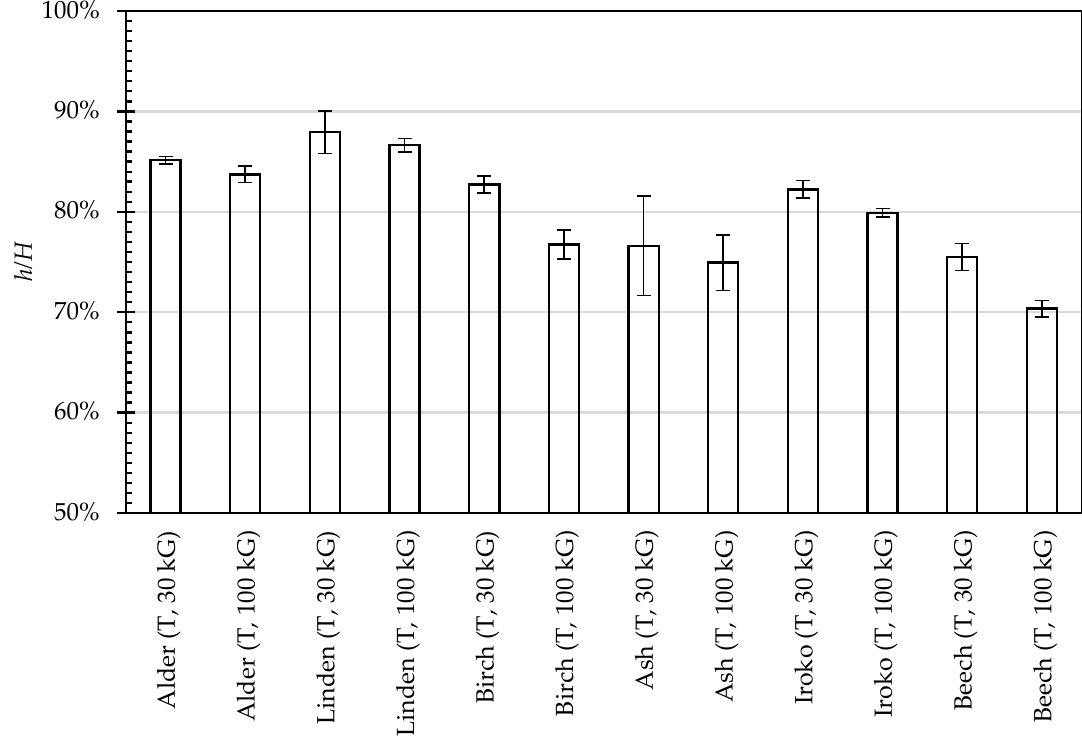
Figure 11. The T cross-section: the permanent imprint depth ( h ) shares the total imprint depth ( H ).